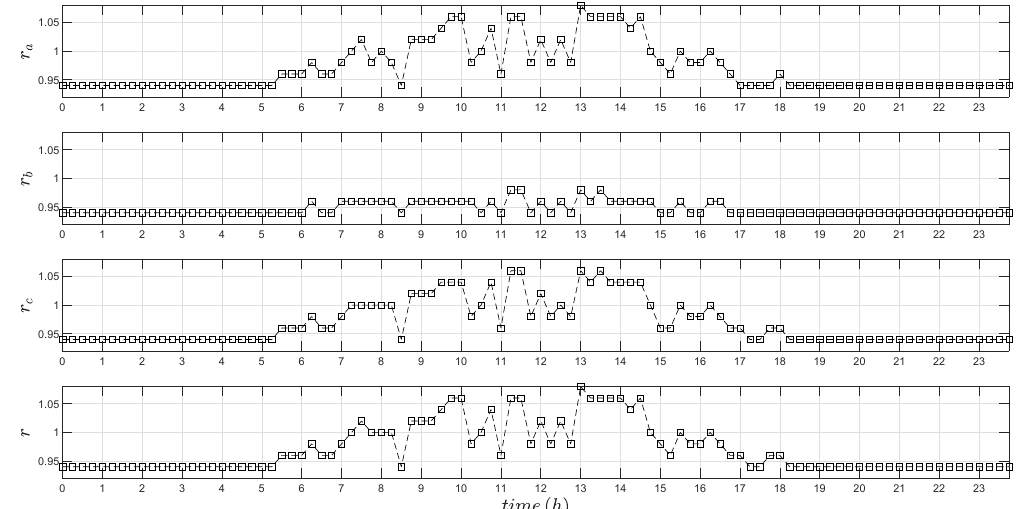
Figure 12. Optimal tap positions when considering a 1P-OLTCTS or 3P-OLTCTS.